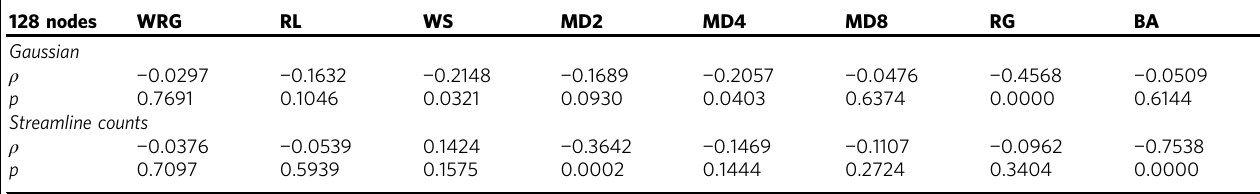
Table 1 Relationship between mean average controllability and modularity Q for various graph types 128 nodes